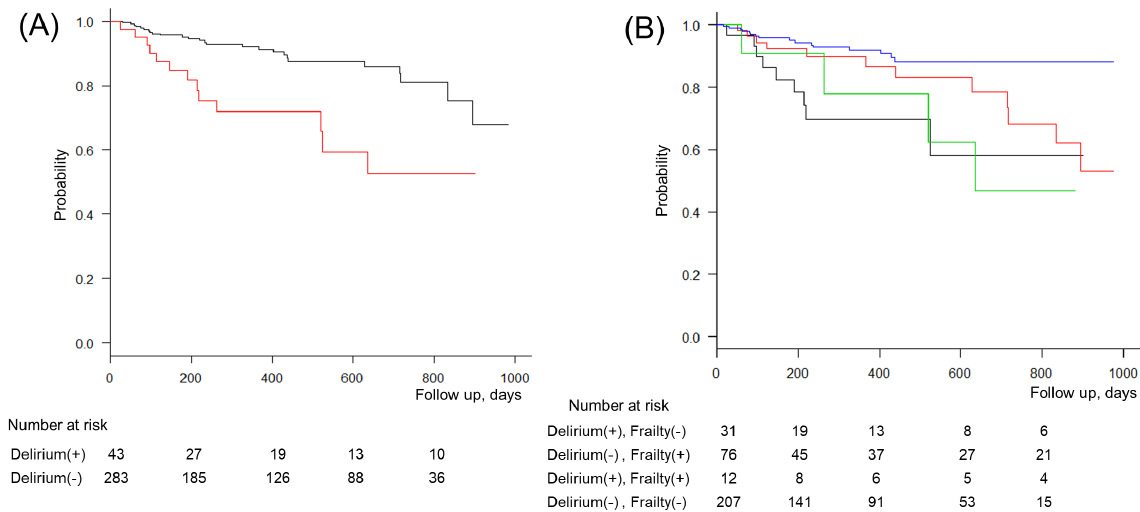
Fig 2. Kaplan–Meier curves for cumulative major adversecardiac events for (A) presence (red line) or absence(black line) of postoperative delirium(Log-ranktest, p = 0.000733),(B) a comparisonof the four groupsrobust (blue line), delirium(black line), postoperative frailty (red line), and combination of both (green line) (Log-ranktest, p = 0.00369).